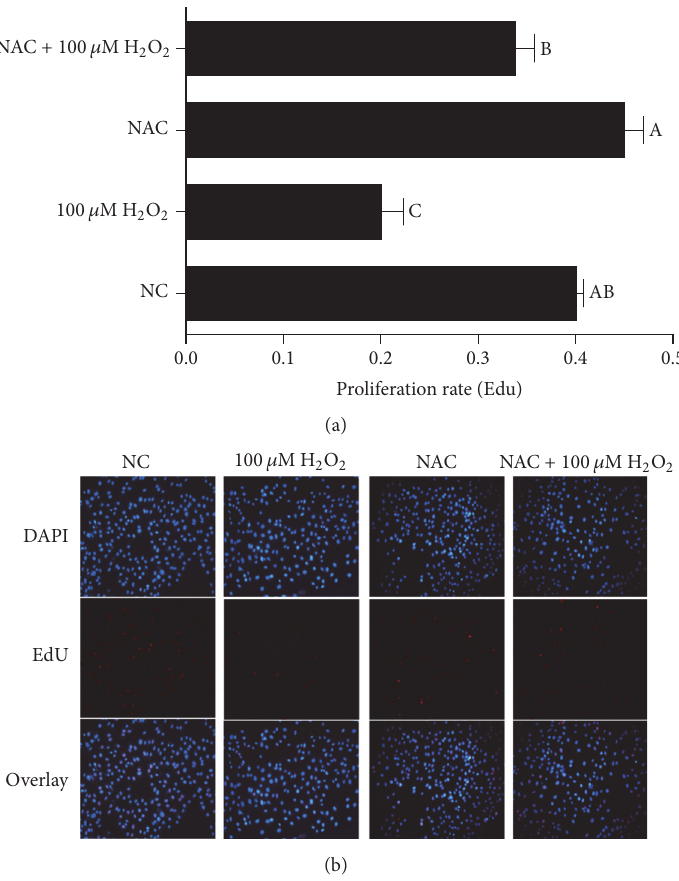
Figure 2: DNA synthesis in IPEC-J2 cells. DNA synthesis during the proliferation of IPEC-J2 cells was quantified by EdU incorporation (red color) using Cell-Light (cid:3) EdU Kit (Rui Bo Biotechnology Limited Company, Guangzhou, China). Nuclei are shown in blue color. Cells were treated with 0 (NC) or 800 𝜇 M NAC and 0 or 100 𝜇 M H 2 O 2 , respectively. (a) The percentage of EdU-positive cells (the number of red nuclei versus the number of blue nuclei in at least five different microscopic fields of vision). (b) Representative images of EdU staining (magnification × 200) of cells. Data are expressed as means ± SEM of at least three independent experiments. a–c Values with different letters are significantly different ( 𝑃 < 0.05